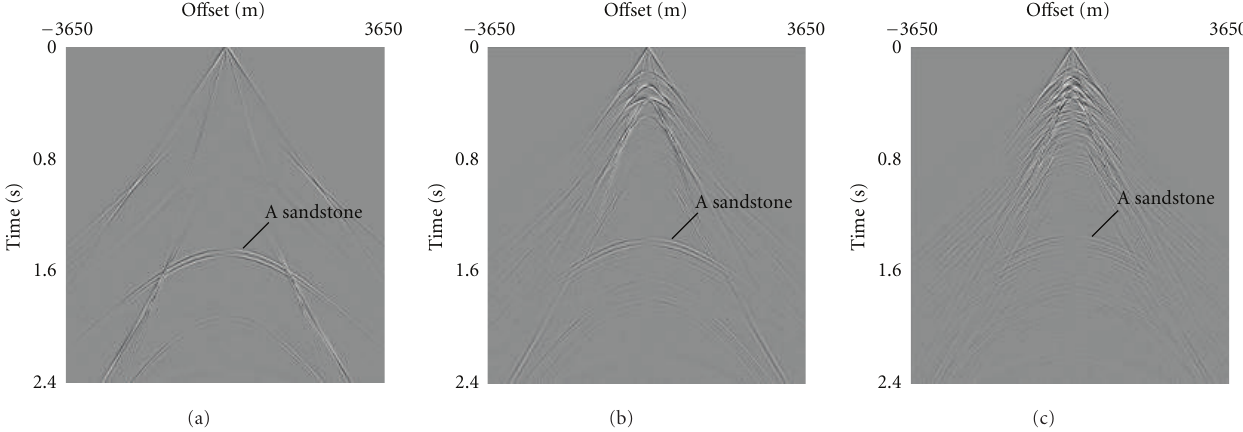
Figure 11: PS-wave gather for the case of (a) Model 1a, (b) Model 1b, and (c) Model 1c, showsthat the amplitude of multiples due to shallow anhydrite layers is comparable to the amplitude of primary